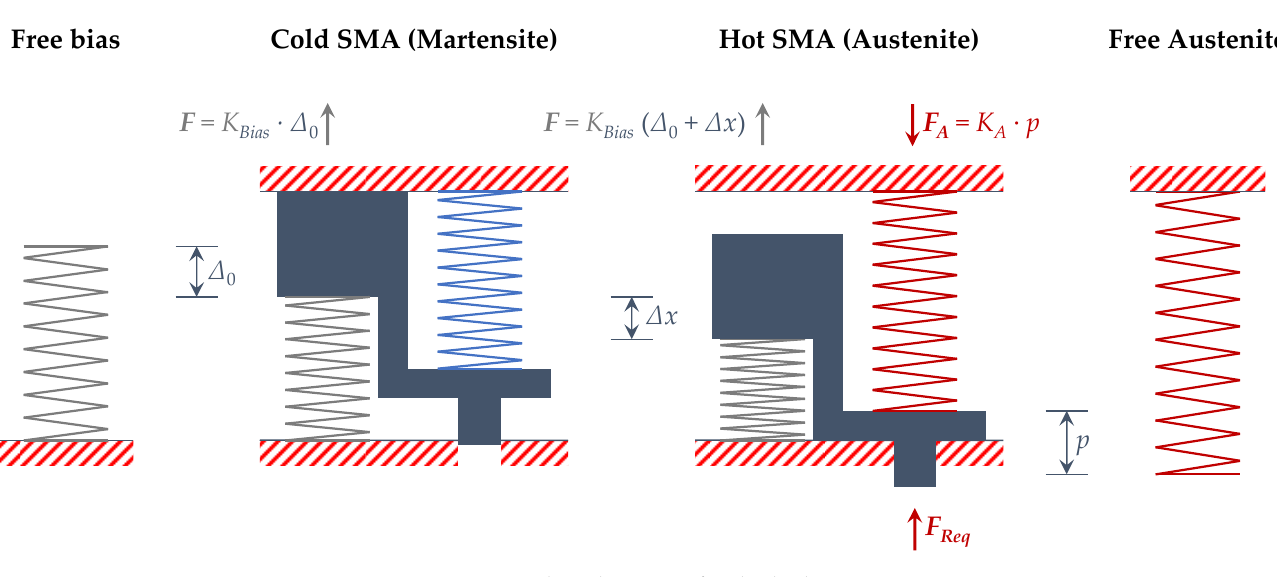
Figure 3. SMA-based actuator free body diagram.